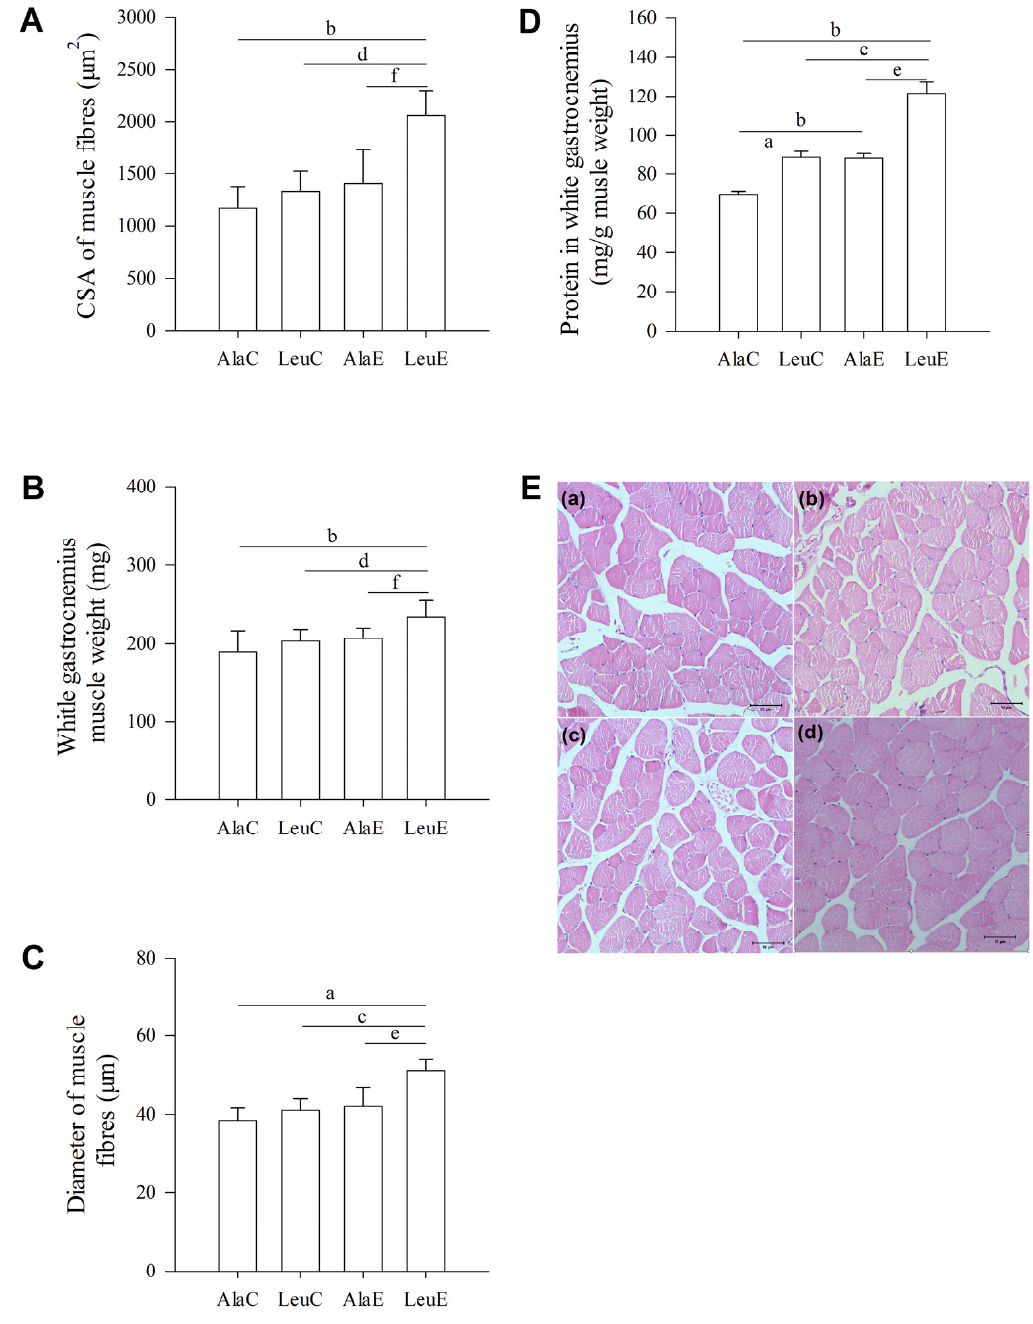
Figure 3. Effects of leucine supplementation and exercise on ( A ) cross-sectional area (CSA), ( B ) diameter, ( C ) weight, and ( D ) protein ratio; ( E ) Hematoxylin-eosin stained sections of white gastrocnemius muscle in mice: ( a ) Cross-section of alanine supplementation; ( b ) leucine supplementation; ( c ) alanine supplementation + exercise training; and ( d ) leucine supplementation + exercise training mice. Magnification 400 ˆ , scale bars = 50 µ m. Values are provided as mean ˘ standard deviation for each group ( n = 7–10). AlaC: alanine supplementation group; LeuC: leucine supplementation group; AlaE: alanine supplementation + exercise training group; LeuE: leucine supplementation + exercise training group. a: p < 0.05 versus the AlaC group; b: p < 0.01 versus the AlaC group; c: p < 0.05 versus the LeuC group; d: p < 0.01 versus the LeuC group; e: p < 0.05 versus the AlaE group; f: p < 0.01 versus the AlaE